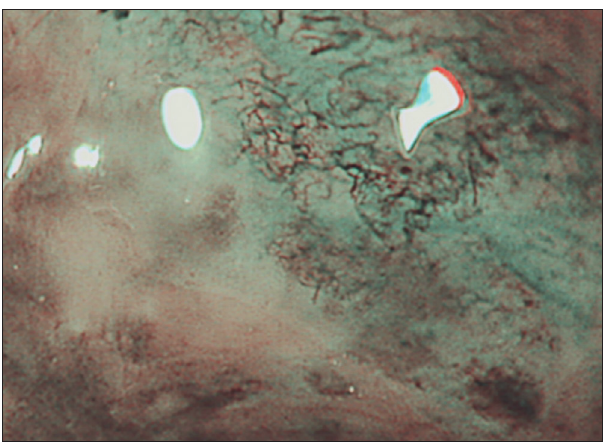
Figure 4) Narrow-band imaging magnification suggesting disappearance of the superficial vascular network at black stripes. Narrow-band imaging magnification between the black stripes revealed dilation and tortuosity of intrapapillary capillary loops without calibre